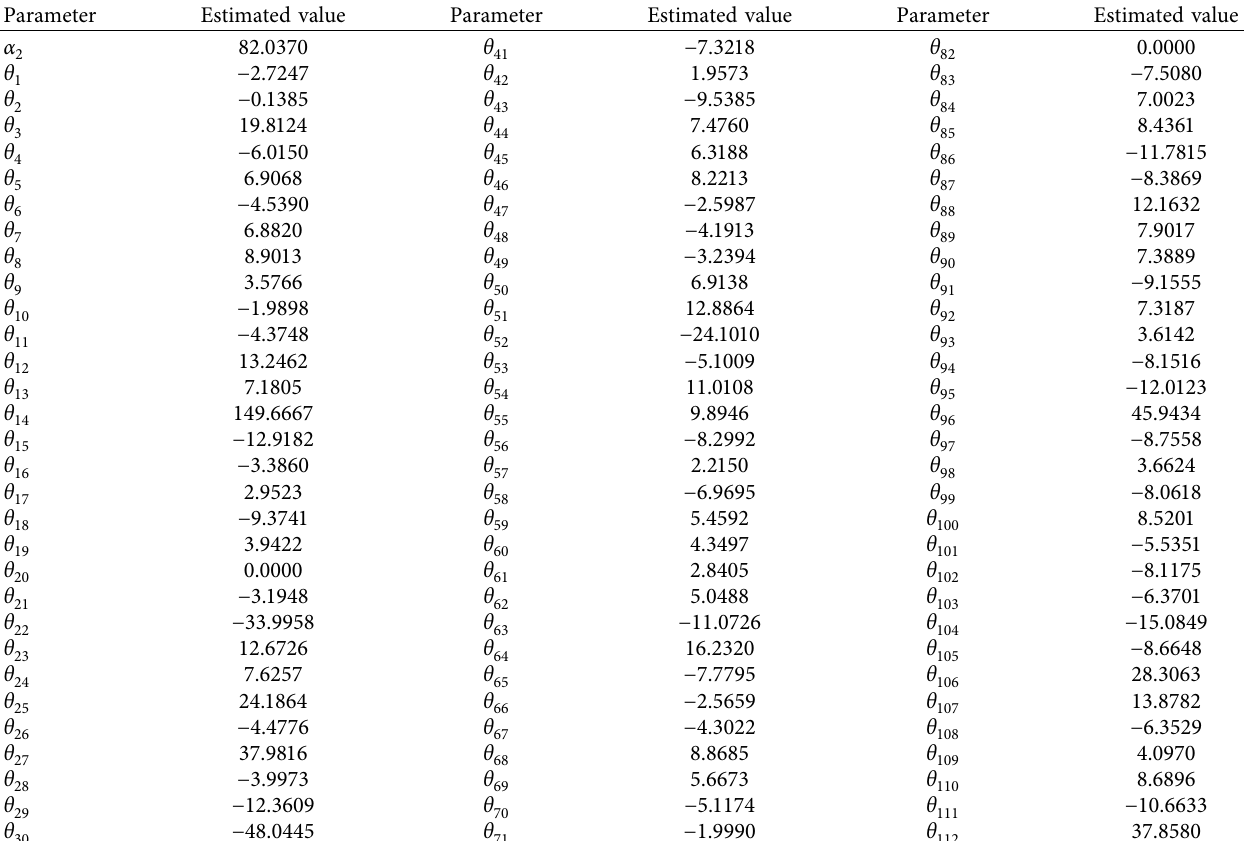
Table 9: Parameters and coefficients’ estimated values in the outflow